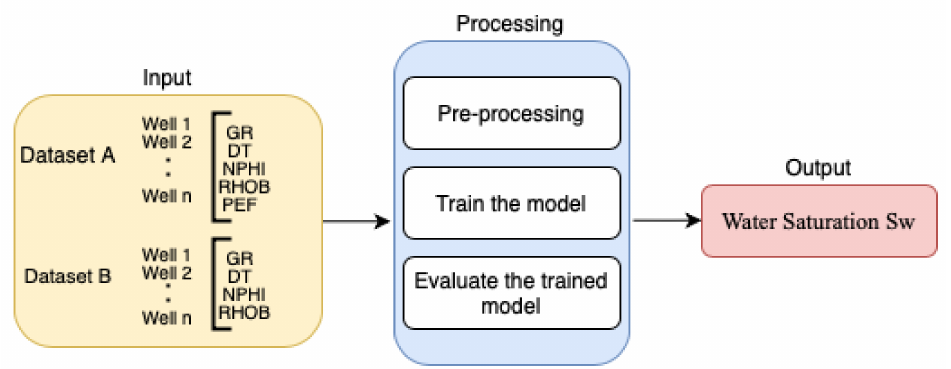
Figure 2. The schematic flowchart for building the ML